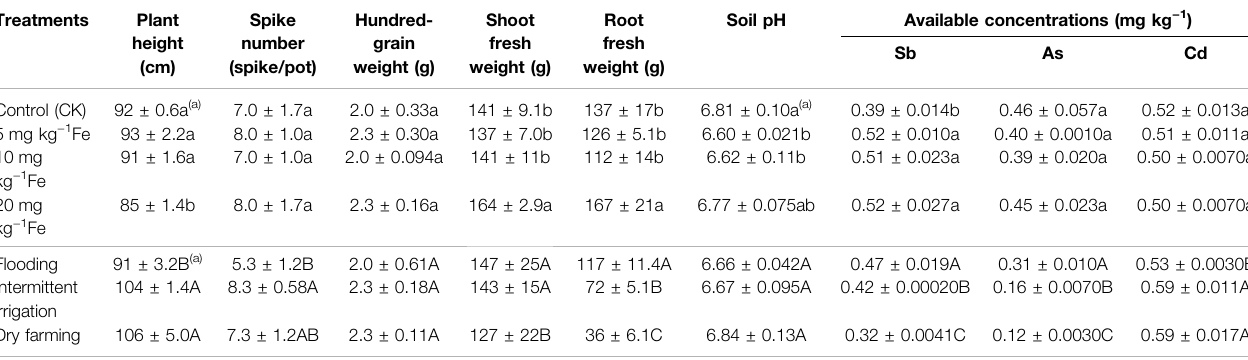
TABLE 1 | Plant growth and soil available concentrations of metal(loid)s.